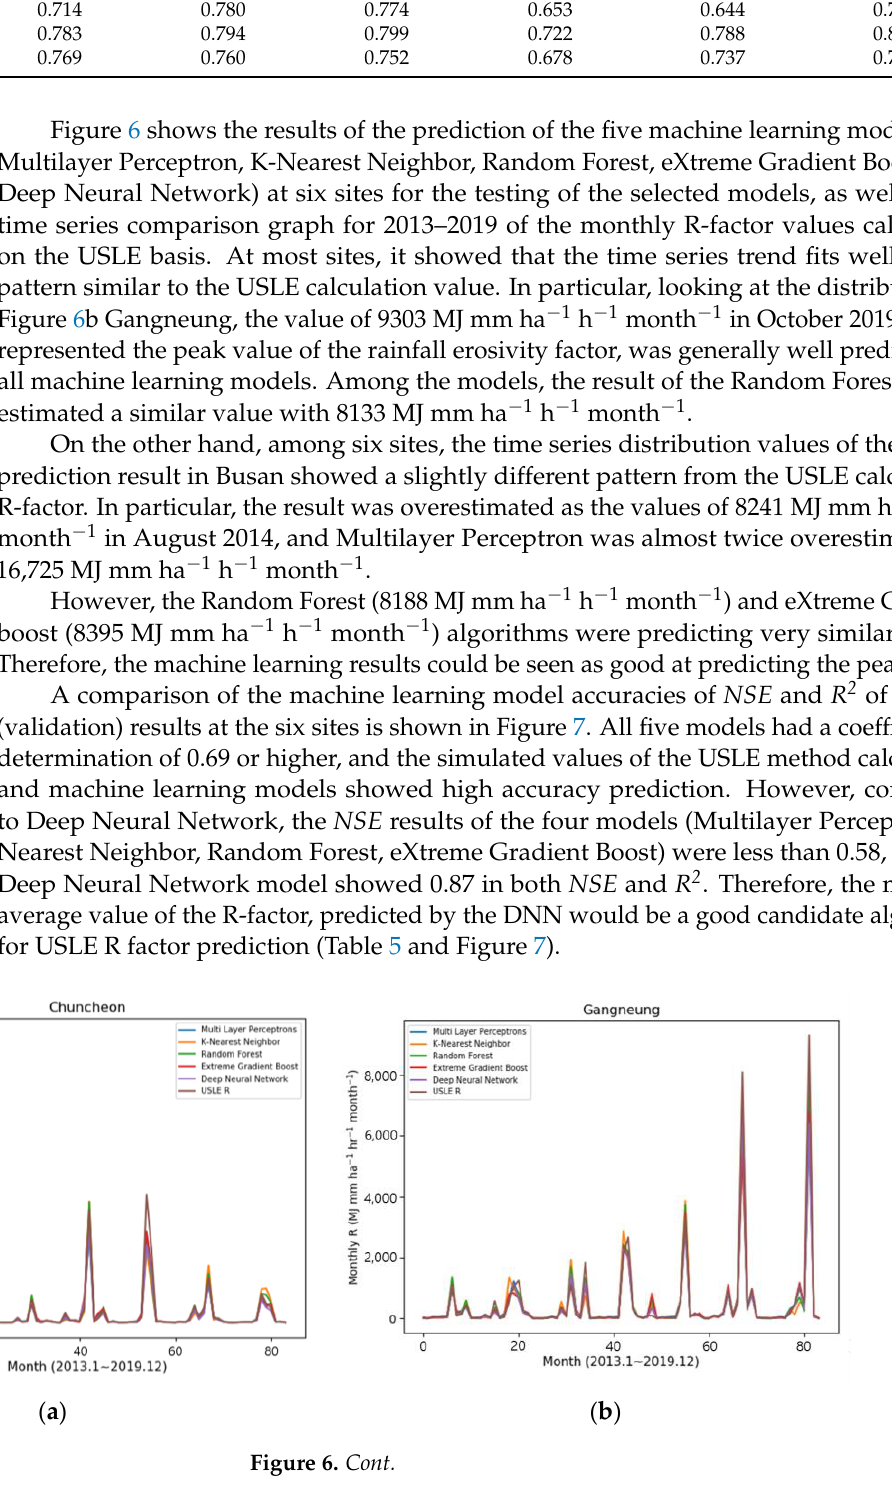
Table 6. K-fold cross validation results of seven machine learning models.